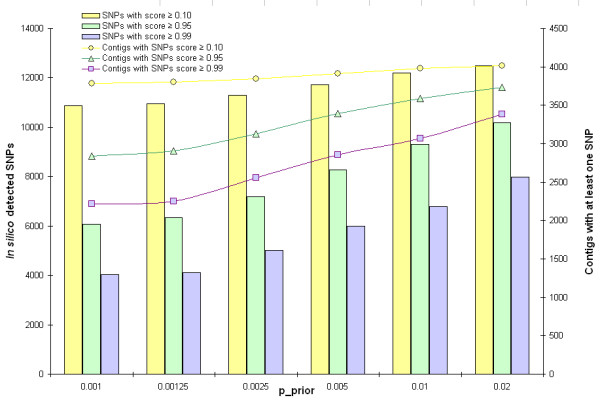
Number of in silico detected SNPs and of snp'ed contigs as a function of the prior probability . P_prior stands for the a priori expected polymorphism rate used by PolyBayes to compute the SNP score PSNP. A value of p_prior of 0.02 means one SNP expected each 50 nt.